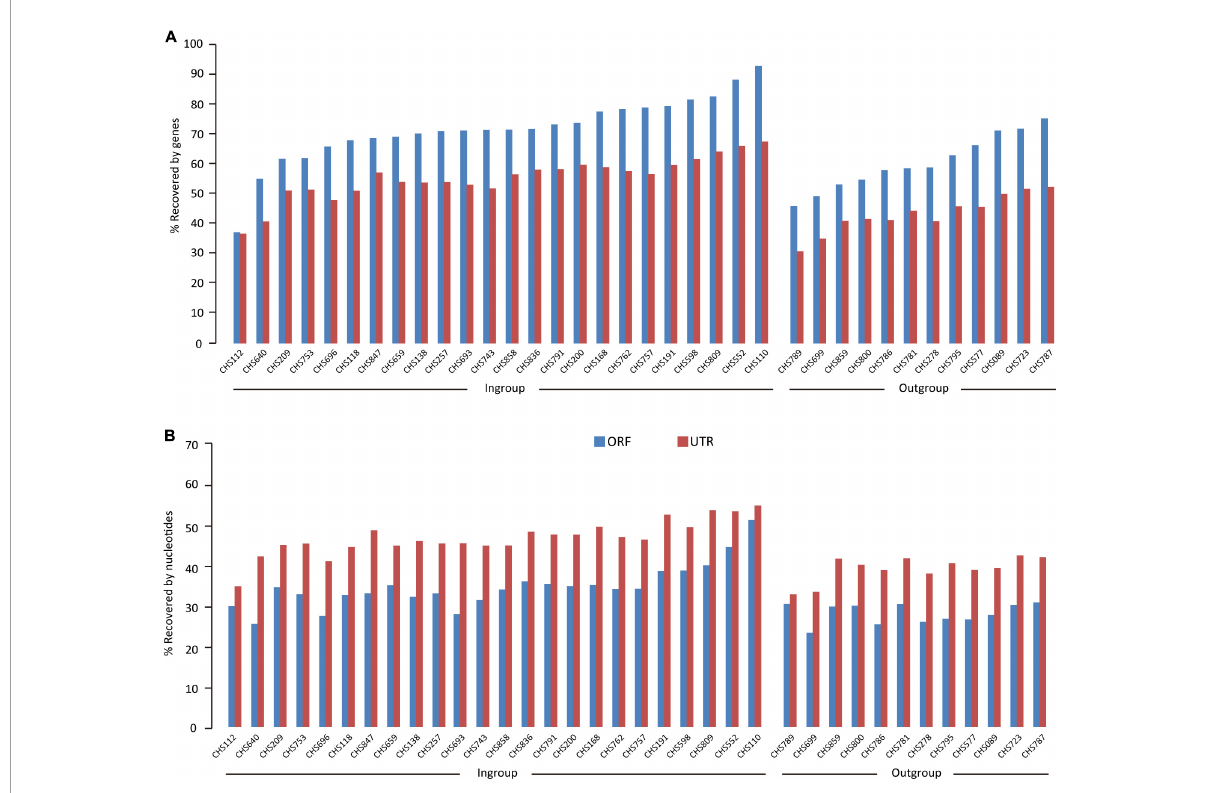
FIGURE3 The results of extracting UTR and ORF sequences from the FLc-Capture data for the ingroup Colubridae species and the outgroup species. Bars show (A) gene recovery rates (B) nucleotide recovery rates.